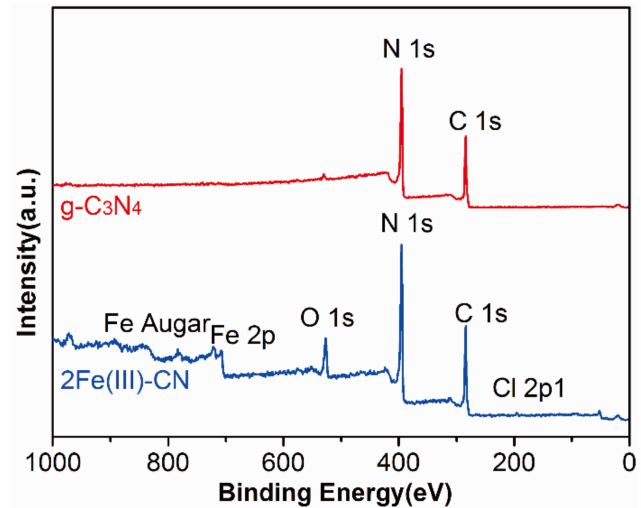
Figure 5. XPS spectra of g-C 3 N 4 and 2Fe( Ш )-CN